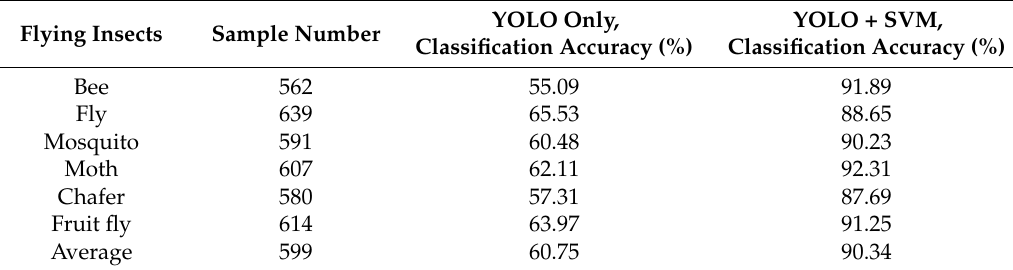
Figure 13. Classification instance of YOLO. The labels 1–7 represent six species of flying insects and other species of flying insects, respectively. Table 4. Classification performance of YOLO.